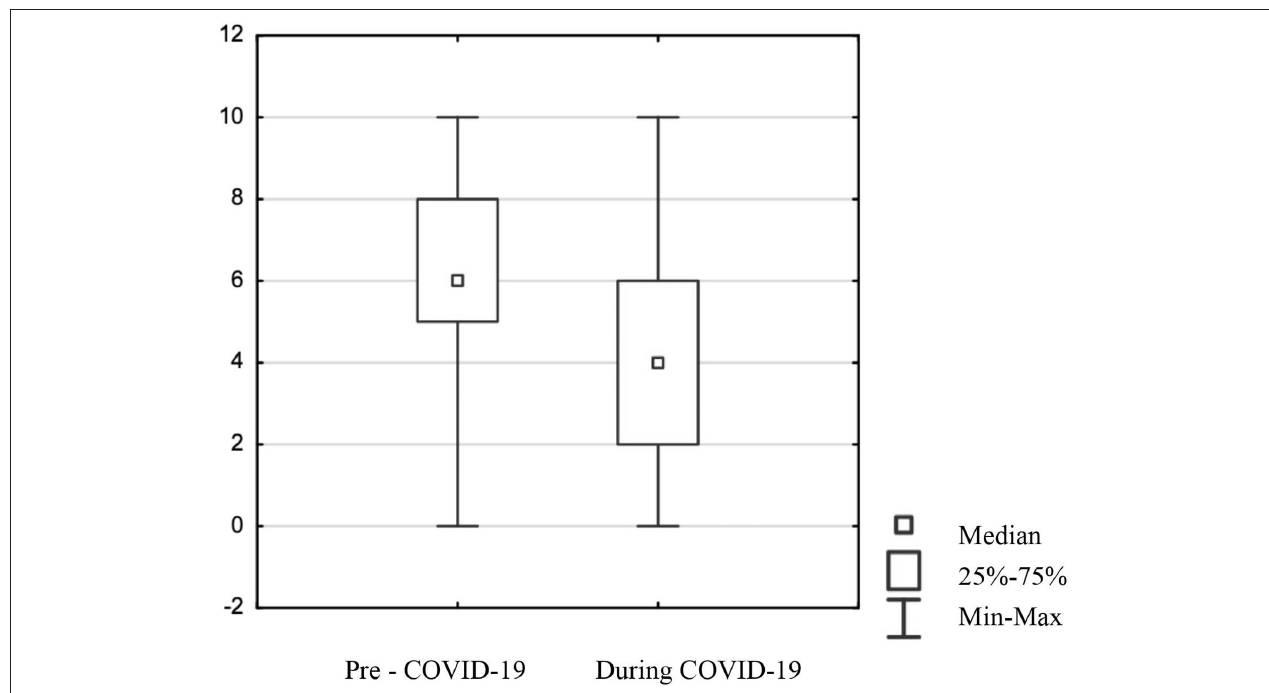
FIGURE 1 | Comparison of respondents’ assessment of the quality of healthcare services in Poland before and during the COVID-19